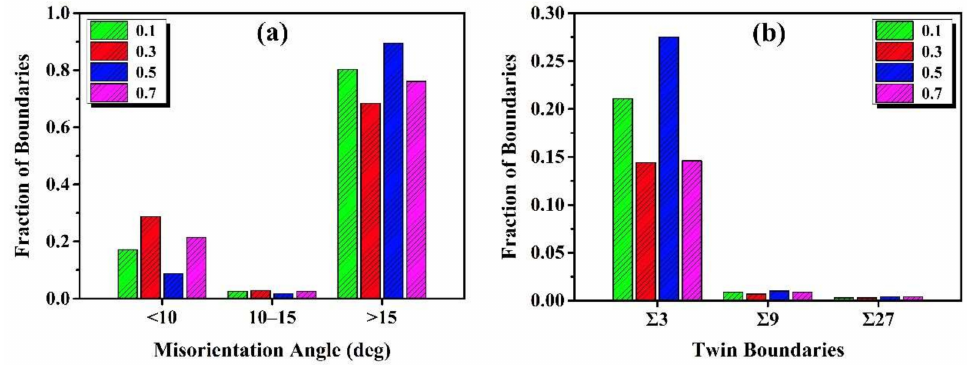
Figure 6. The distribution of grain boundary misorientation ( a ) and the fraction of Σ 3, Σ 9 and Σ 27 boundaries ( b ) of GH4151 samples deformed at di ff erent strains of 0.1, 0.3, 0.5 and 0.7,